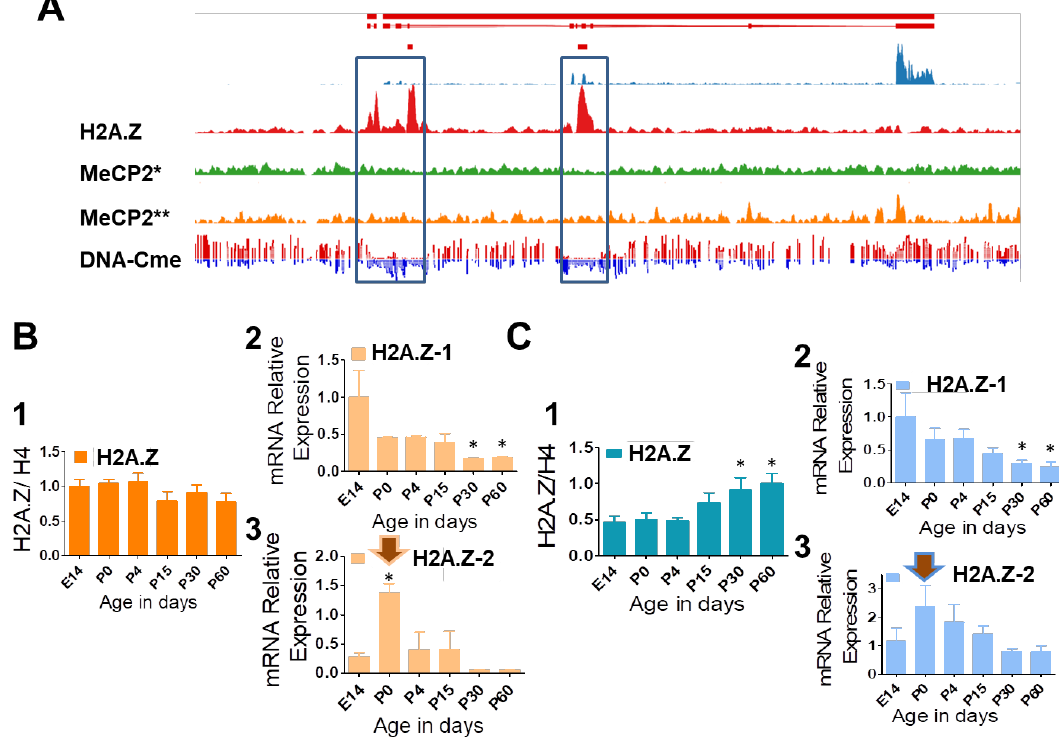
Figure 4. ( A ) Schematic view of the genomic (solid red line) and coding (thin red line) representation of the BDNF gene and integrative genomics viewer (IGV) profiles of: mRNA–seq (blue) [86]; H2A.Z (red) [86]; MeCP2* (green) [82]; MeCP2** (orange) [80]; whole-genome bisulfite sequencing (red and blue): red reads are 5mC and blue reads are unmethylated cytosines. Notice that H2A.Z binds to unmethylated C (dataset provided by Andrew J. Kennedy and Kristine E. Zengeler). * https: // www.ncbi.nlm.nih.gov / geo / query / acc.cgi?acc = GSE60071. ** https: // www.ncbi.nlm.nih.gov / geo / query / acc.cgi?acc = GSM494290. ( B , C ) Developmental H2A.Z protein expression via quantitative western blot (1) and isoforms H2A.Z-1 and H2A.Z-2 relative mRNA expression levels via qRT-PCR (2, 3) in mouse brain (B) and liver (C). One-way ANOVA with Dunnett’s multiple comparison was performed to analyze western blot ( n = 3) and qRT-PCR data ( n = 5). E14 was used as a reference. Significance: * p <